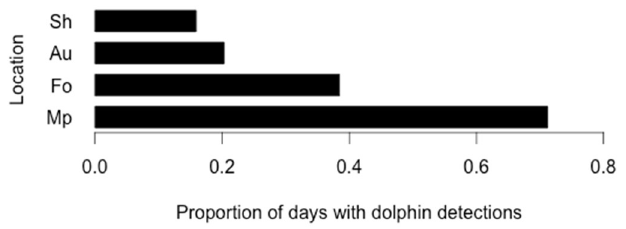
Figure 3. Summary of the proportion of days with dolphin detections per location across their respective study periods (Mp = Moneypoint, Fo = Foynes, Au = Aughinish and Sh = Shannon Airport).